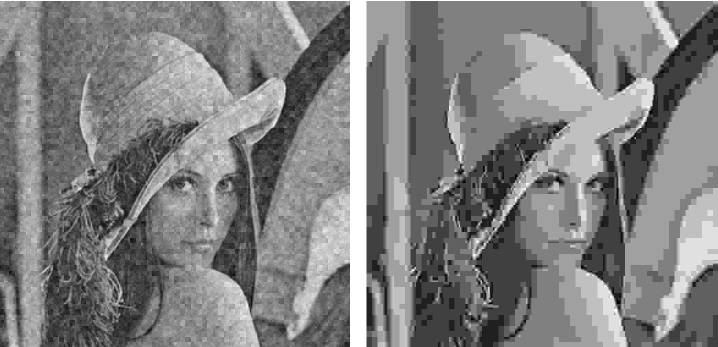
Figure 5. Output images. Left hand side : Lena, analog transmission, 0.59 structural similarity (SSIM). Right hand side : Lena, JPEG encoding, 0.64 SSIM.